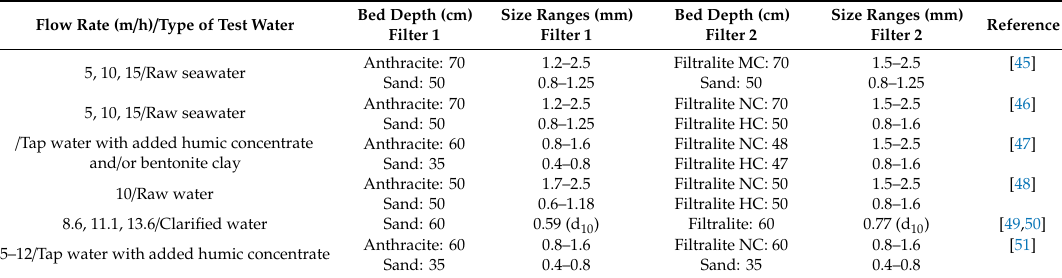
Table 1. Comparison of relevant parameters for studies on